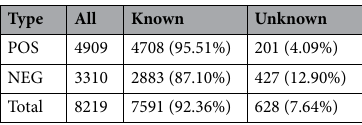
Table 2. Metabolite identification